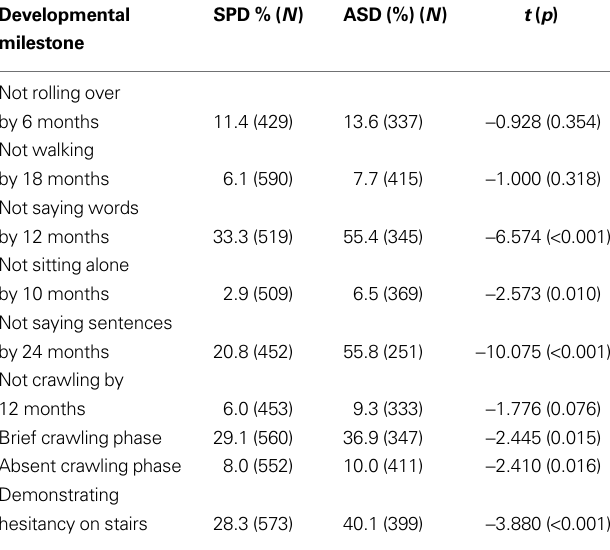
Table 8 | Percentage, valid N , and T -tests of early childhood developmental milestones.